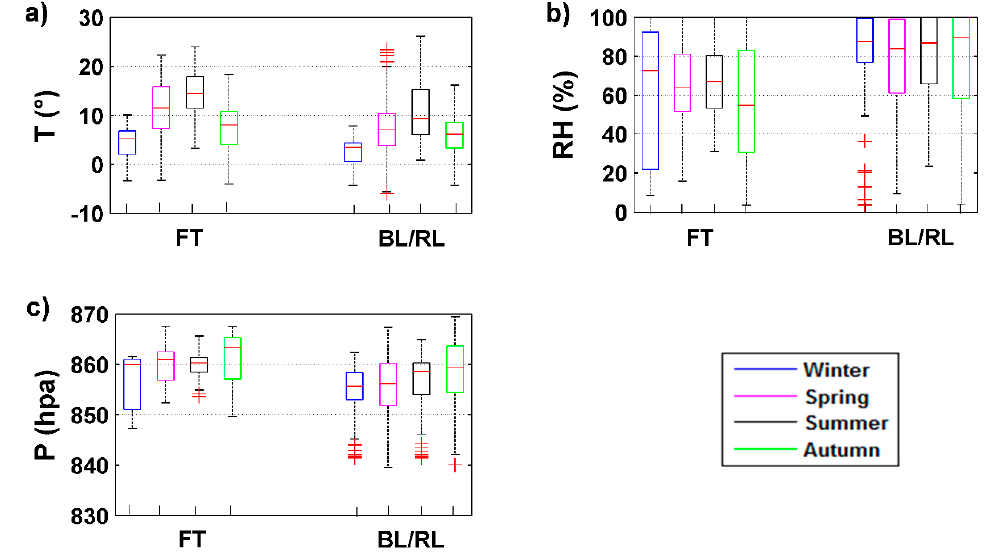
Figure 8. The FT/(BL/RL) variation of ( a ) Temperature (T); ( b ) Relative Humidity (RH), and ( c ) pressure (P), for the four seasons at the PUY station. Red lines represent the median value, bottom and top sides of the boxes symbolize the 25th and 75th percentile respectively and the extremities of the black lines are the 10th and 90th percentile. Red Crosses represent the outliers.